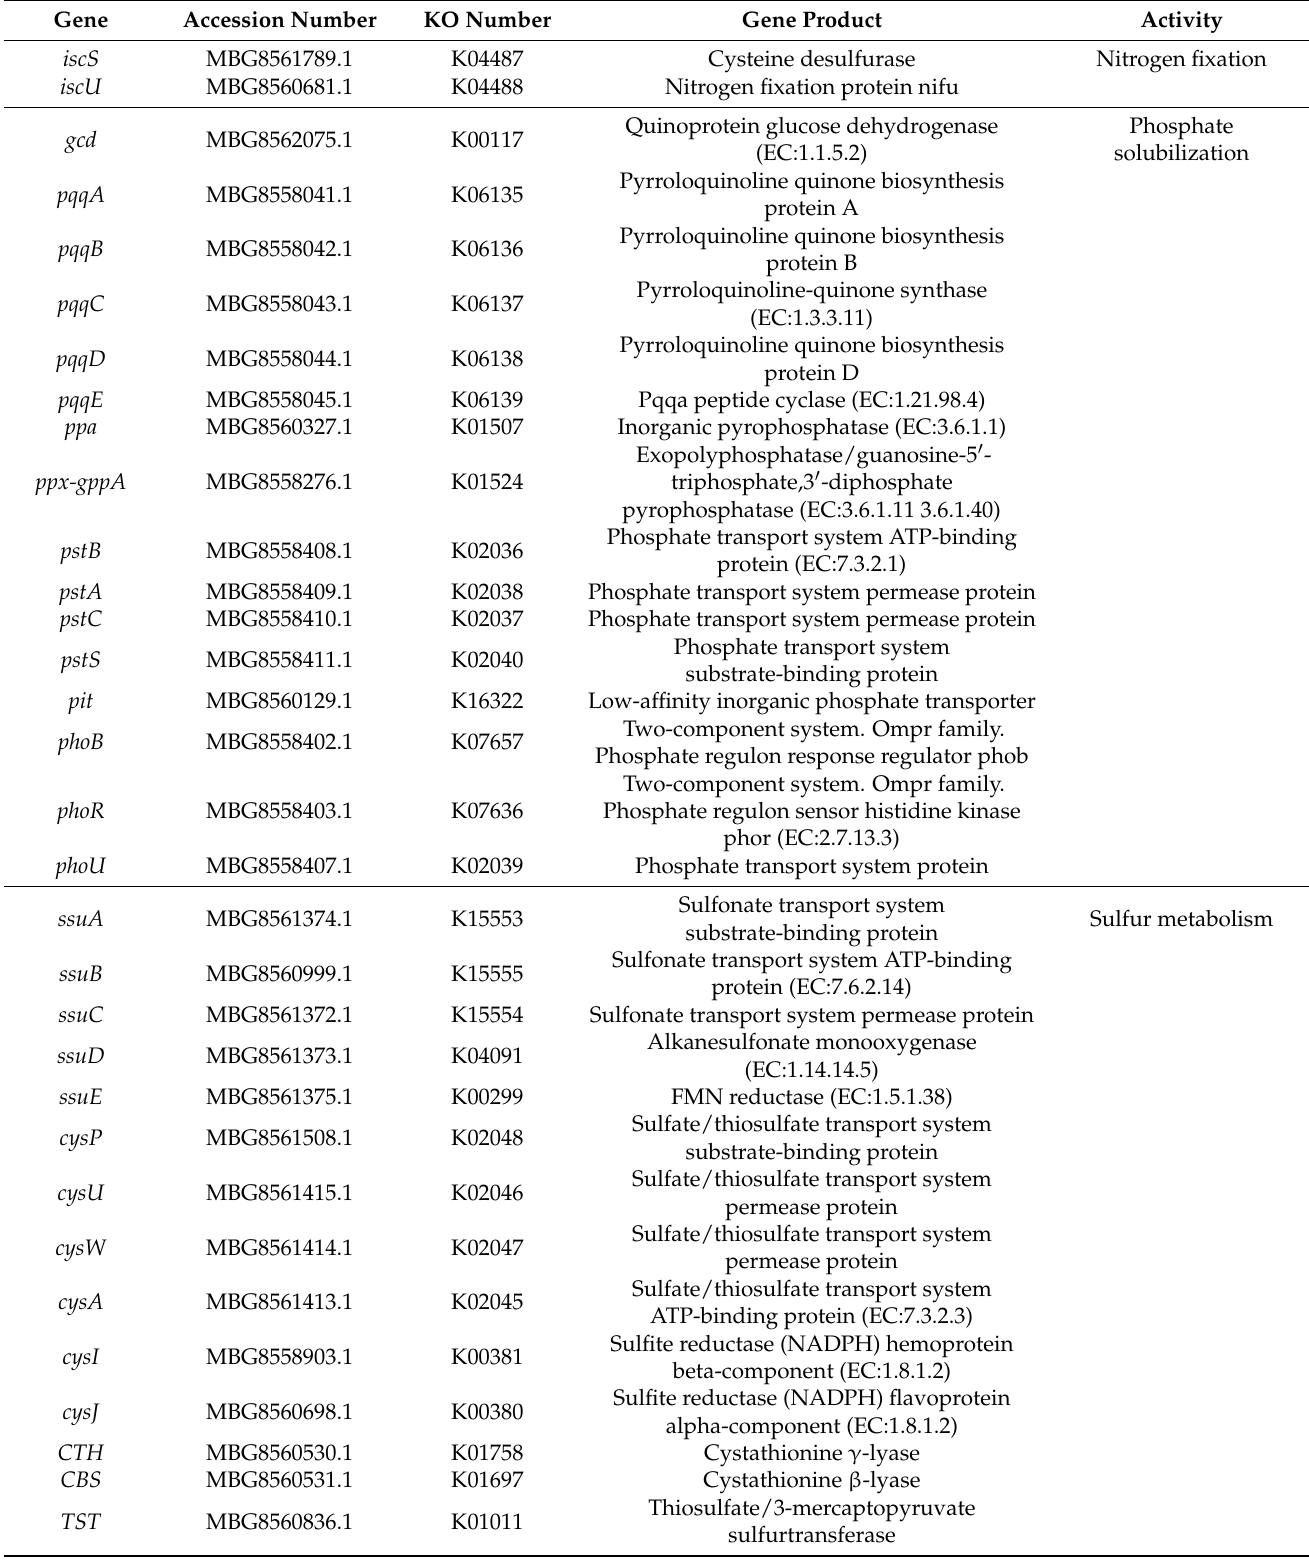
Table 4. Products of the genes involved in the most important plant growth promotion traits present in the genome of the ZCR6